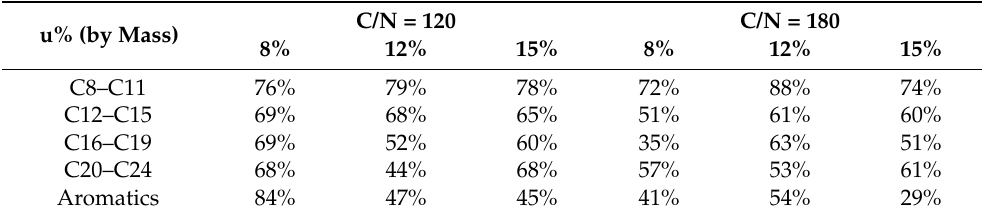
Table 7. Removal efficiency, η H , for the hydrocarbon clusters and aromatics in the microcosms with C/N = 120 and 180 after 138